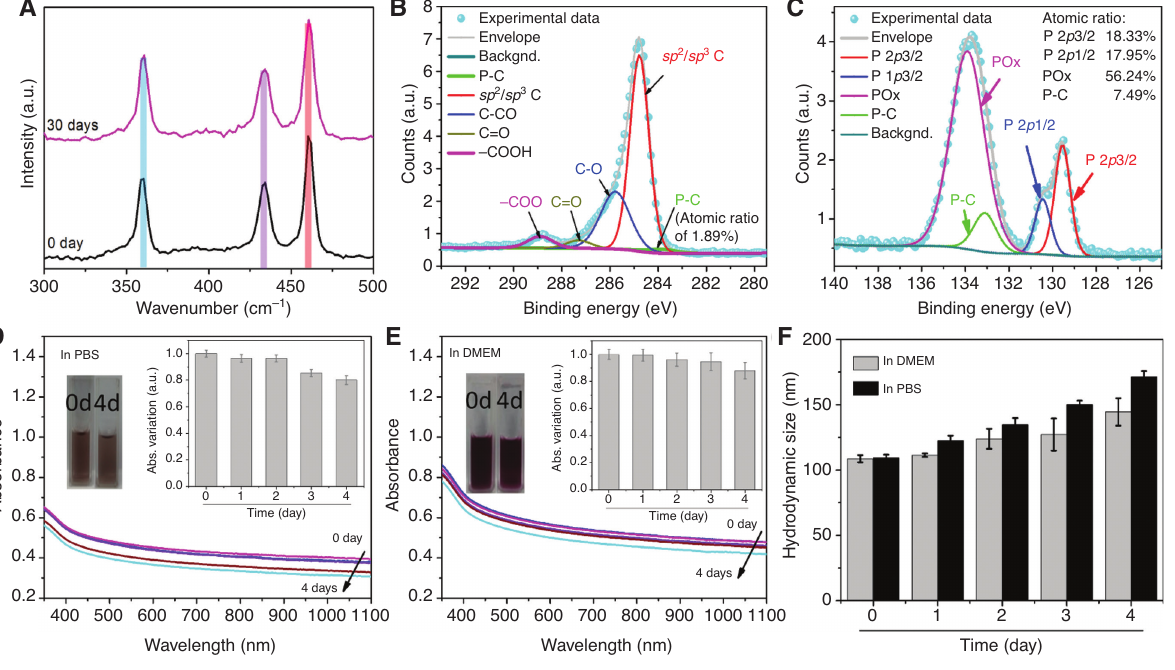
Figure 3: Stability of BP/rGO in ambient condition and in bio-solution. (A) Raman spectra of BP/rGO before and after storage in ambient condition for 30 days. The Raman spectra were collected under 532.1 nm laser excitation. (B, C) XPS spectra with high resolution of freshly made BP/rGO, which correspond to C Absorption spectra of the PEG-coated BP/rGO, where PEG-coated BP/rGO hybrids were stored in PBS and in DMEM medium for 4 days (4 ° C), respectively. Insets in (D, E): photographs and variation of the absorbance normalized ratios (A/A0) at 808 nm. (F) Changes of hydrodynamic sizes of PEG-coated BP/rGO over time, where PEG-coated BP/rGO hybrids were dispersed in PBS and in DMEM medium,